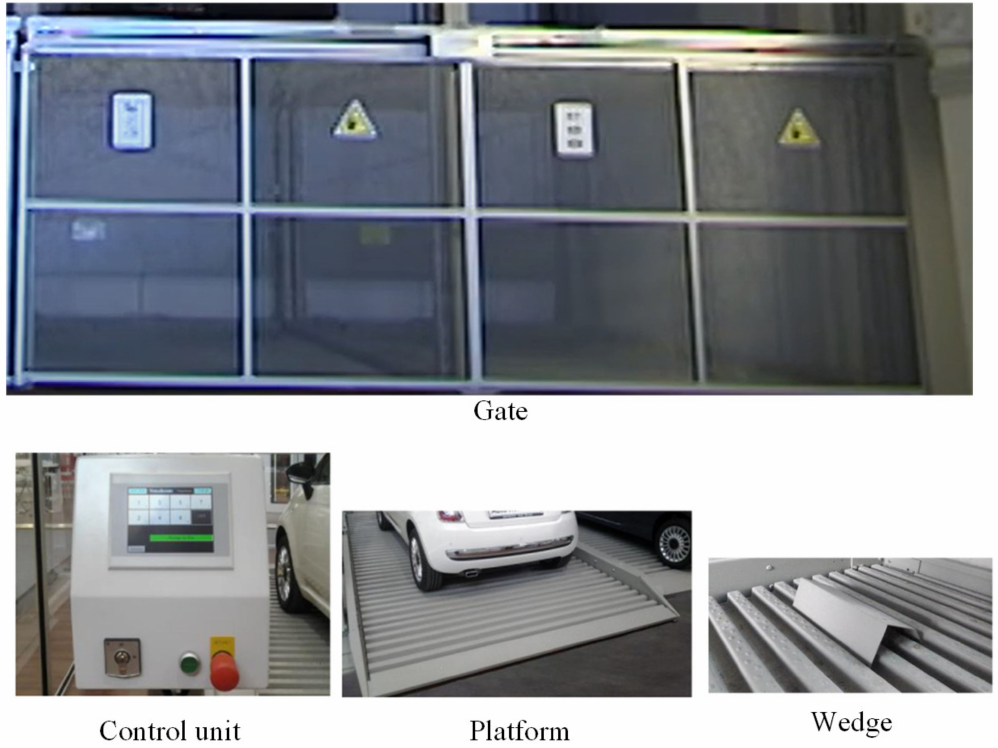
Figure 9. The System-of-Interest (SOI): main